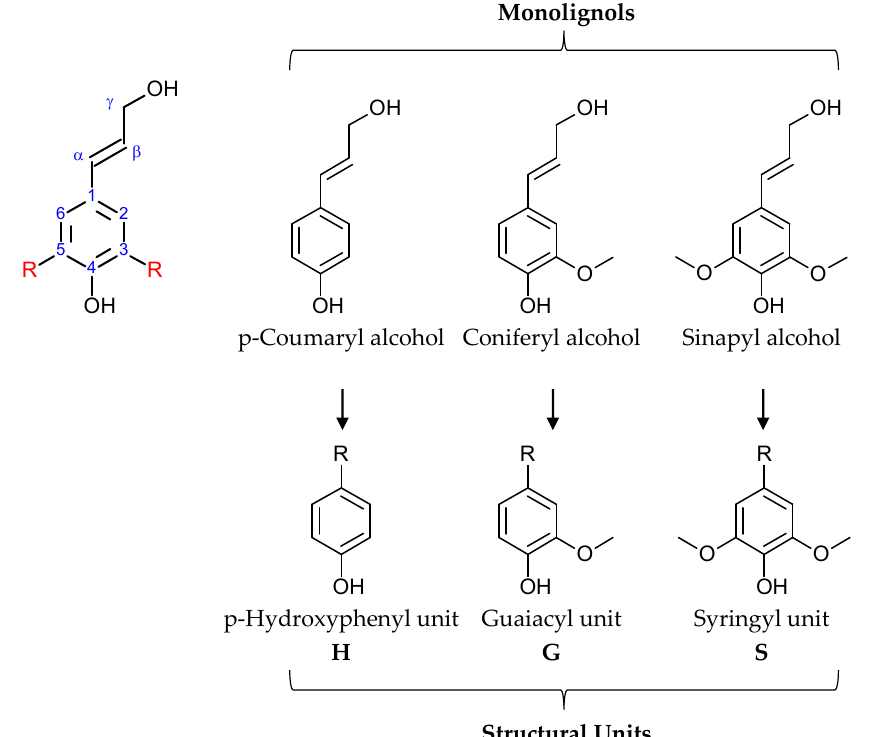
Figure 1. Structure of monolignols and their corresponding structural units.